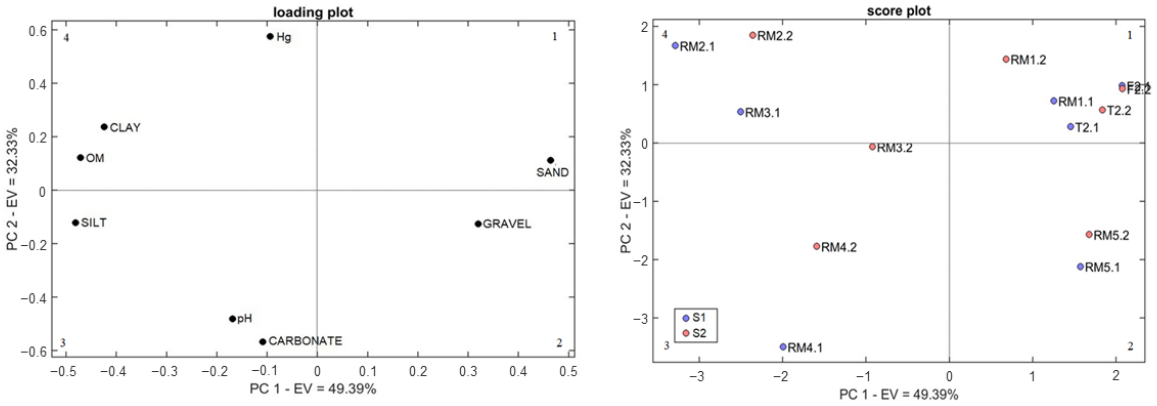
Figure 3. Principal component analysis with the physical-chemical characteristics of the sediment and Hg concentration.